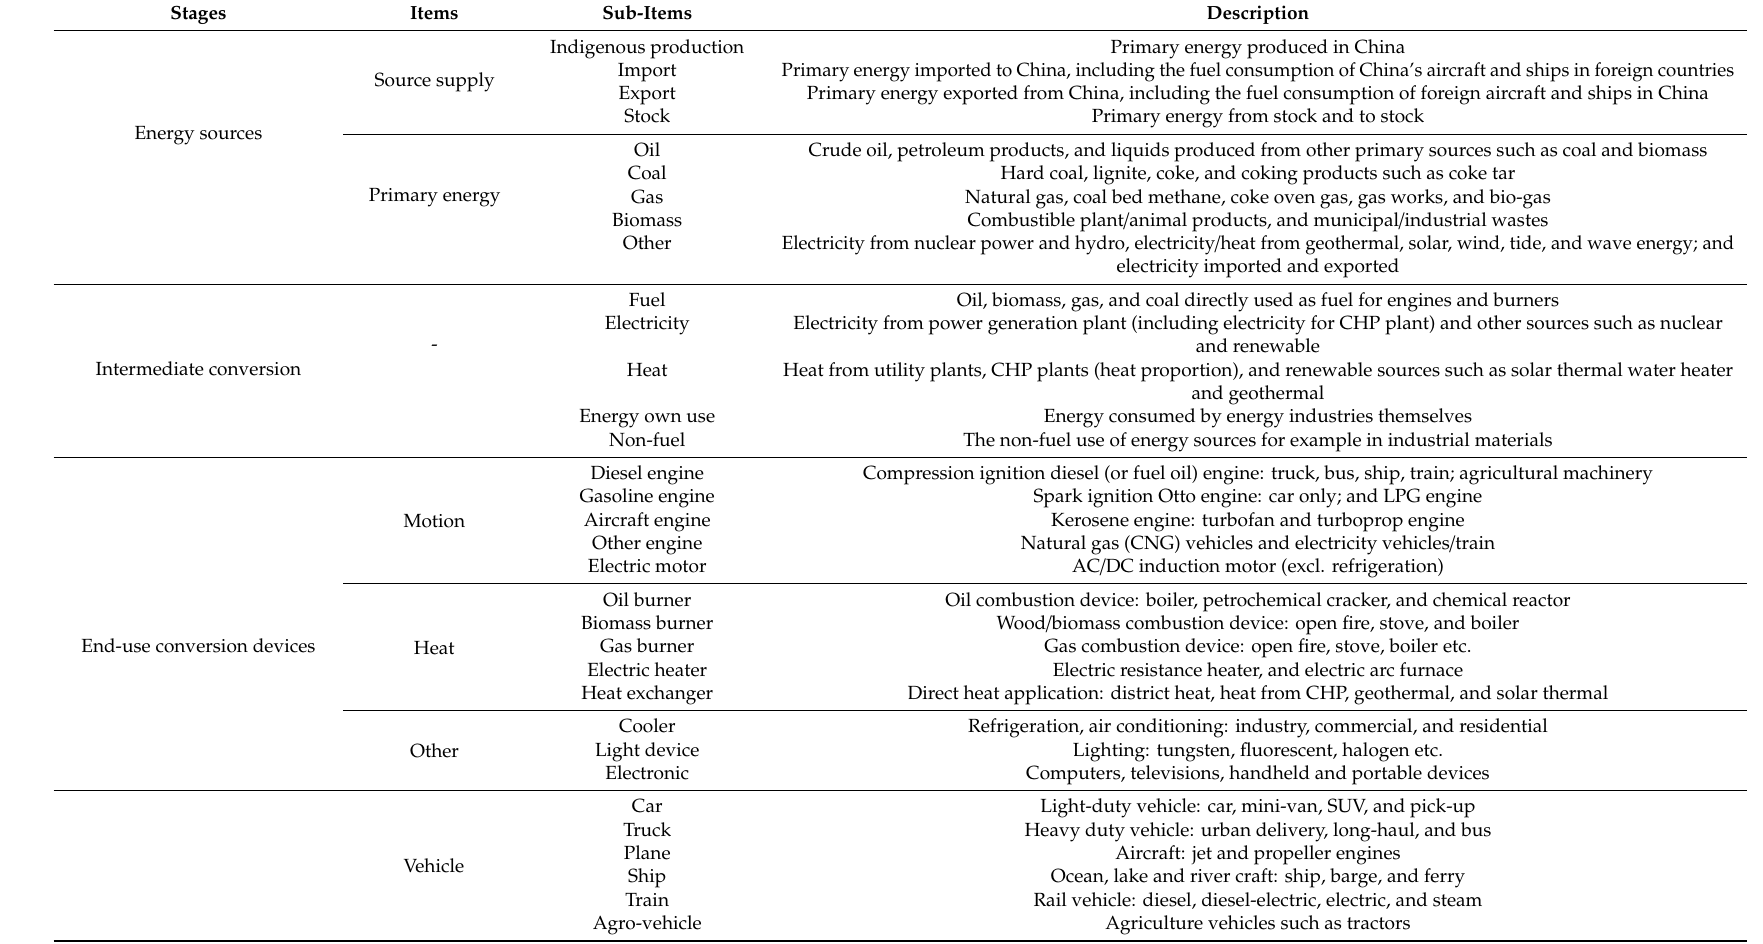
Table A2. Classification and description of each part in the Sankey diagram 1